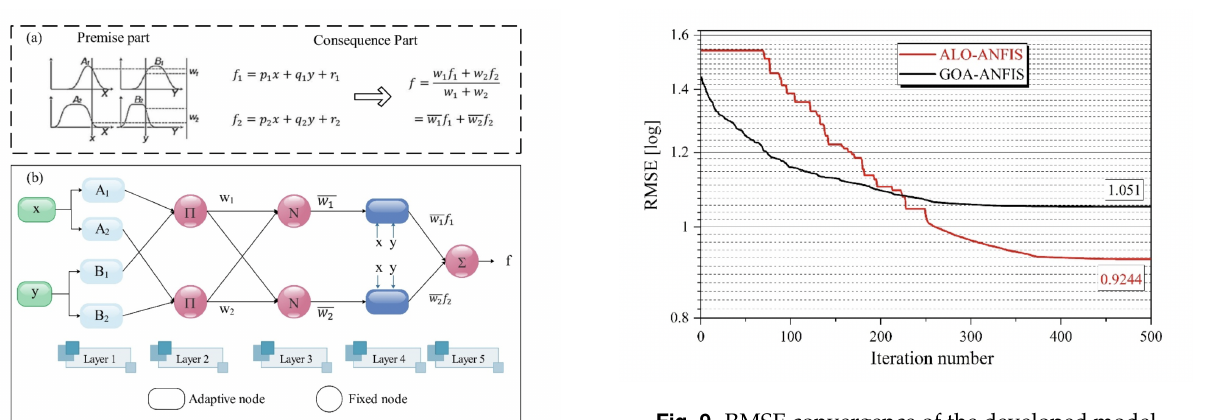
Fig. 9. RMSE convergence of the developed